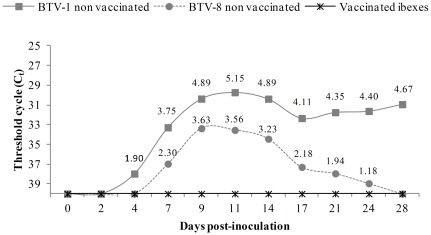
Detection of viraemia after BTV inoculation.Threshold cycle (Ct) values of real-time RT-PCR from blood samples of vaccinated and non vaccinated ibexes challenged with BTV-1 and BTV-8. Negative results are shown as a Ct of 40. Superscripts indicate the estimated BTV titres (TCID50/ml).